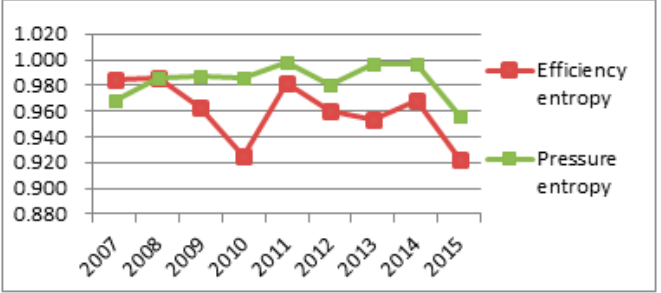
Figure 7. Entropy flow change in the ecological subsystem.